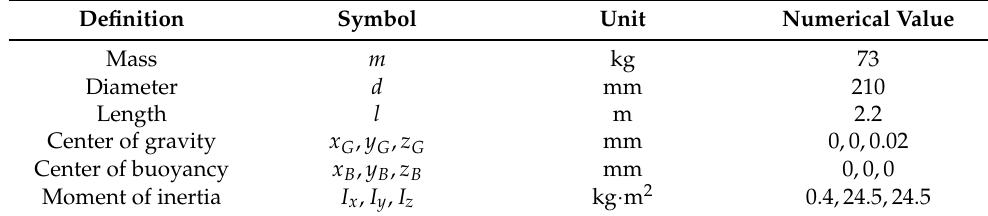
Table 1. The parameters of the AUV model.